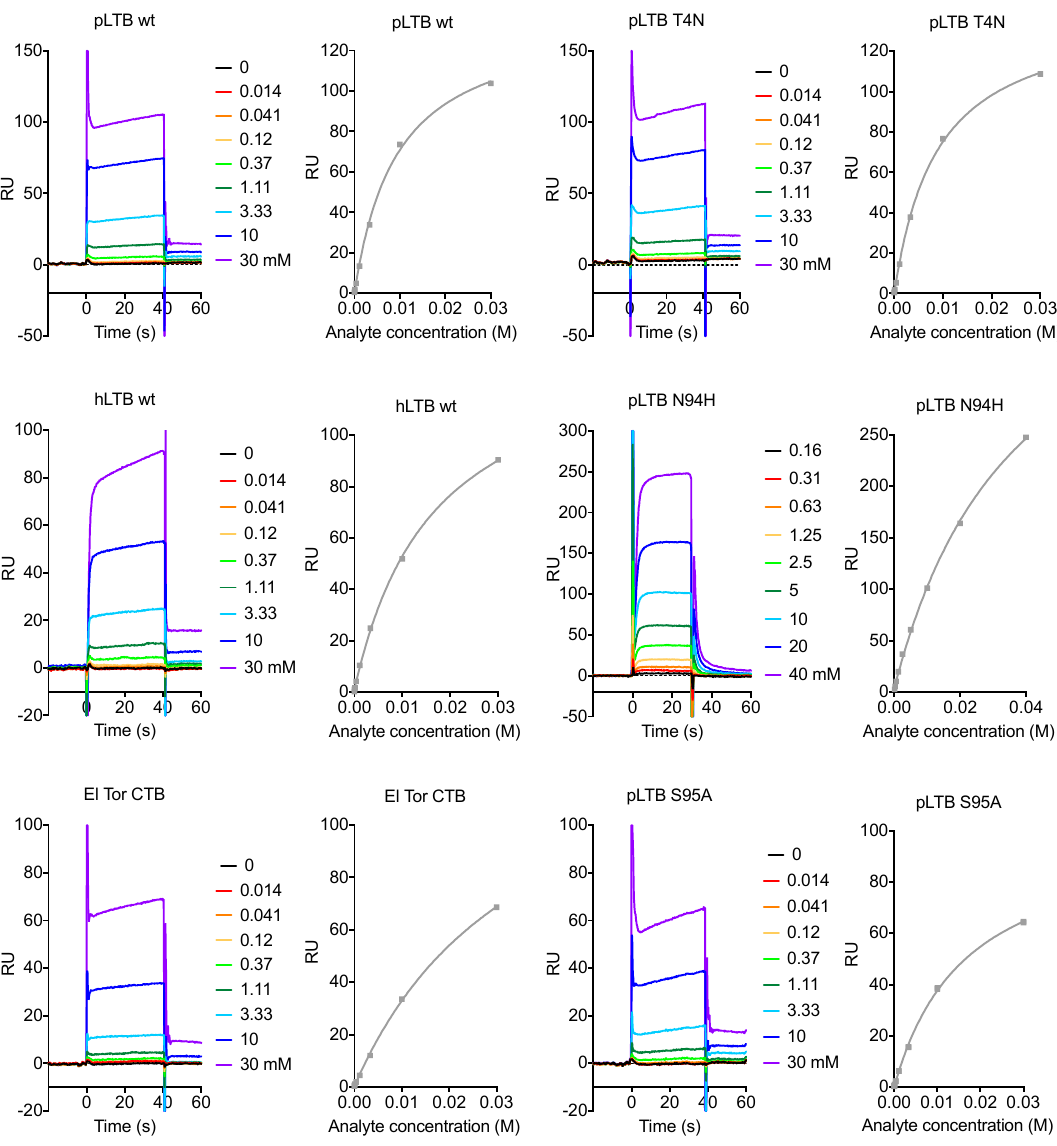
Figure 2. Selected SPR sensorgrams and affinity plots for analyte LNnT. The colored graphs are responses to increasing concentrations of the analyte LNnT, in multi-steady state affinity experiments (response units (RU) versus analyte concentration). The resulting steady-state values are plotted as dots with a fitted curve, using the Biacore T100 evaluation software. The responses are dependent on the protein immobilization rates, therefore the RU-axes are not comparable between protein variants.